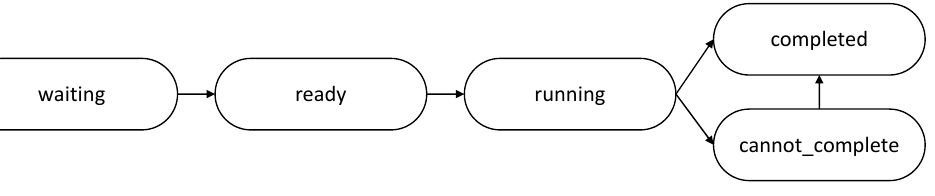
Figure 4. State machine of a subtask status.